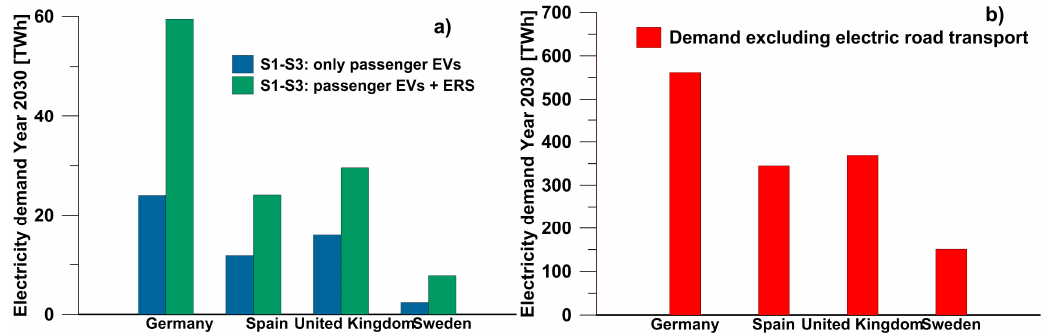
Figure 2. ( a ) The electricity demands in Year 2030 for the scenarios with static charging of passenger electric vehicles (EVs) (blue bars), and with static charging of passenger EVs and electric road systems (ERS) for all other vehicles and for those trips with passenger EVs that cannot be completed using exclusively electricity from the battery (green bars). ( b ) The electricity demand Year 2030 for all loads excluding road transport (red bars).